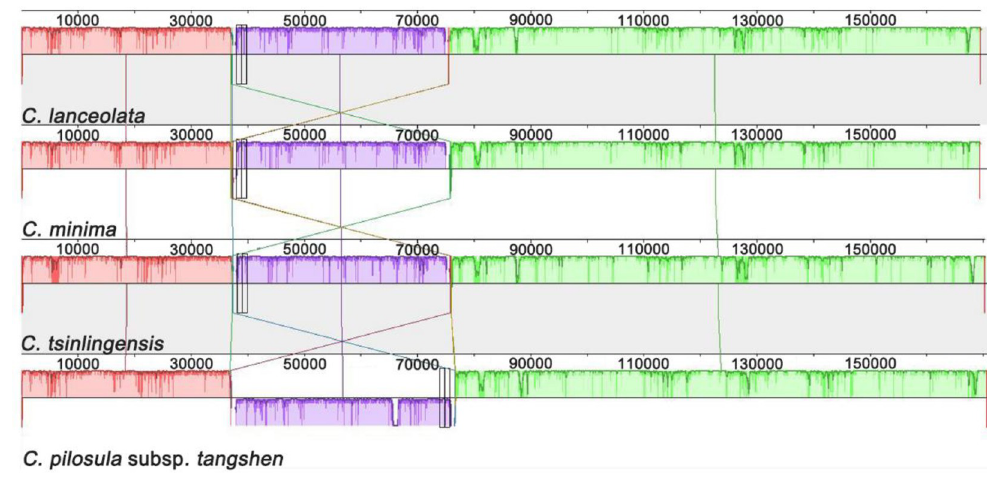
Fig 4. Structure variation in C . pilosula subsp. tangshen . A comparison of tangshen plastome from this study and C . lanceolata , C . minima , and C . tsinglingensis from NCBI revealed similarities and differences in syntenic blocks. The box in purple indicates the correspondence of the region in different species. The C . pilosula subsp. tangshen was used as the reference. An inversion was found in C . pilosula subsp. tangshen was shown in